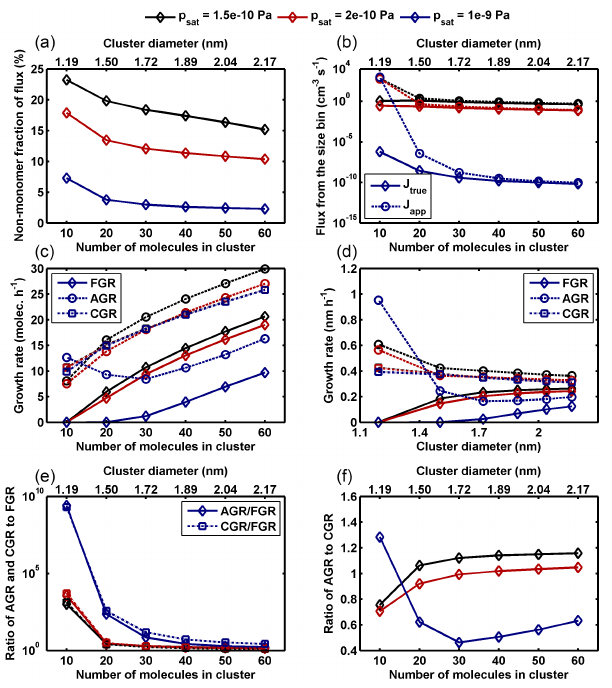
Figure 2. The effect of saturation vapor pressure (shown as dif- ferent colors) on quantities describing cluster growth: (a) the non- monomer fraction of flux from each size bin; (b) the true collision– evaporation flux from each size bin ( J true ; solid line) and the fluxes calculated from the appearance times of clusters ( J app ; dashed line); (c, d) the flux-equivalent growth rate (FGR; solid line), the growth rate derived from the appearance times of clusters (AGR; dashed line), and the growth rate calculated based on irreversible vapor con- densation (CGR; dotted line); (e) the ratios of AGR to FGR (solid line) and CGR to FGR (dotted line); (f) the ratio of AGR to